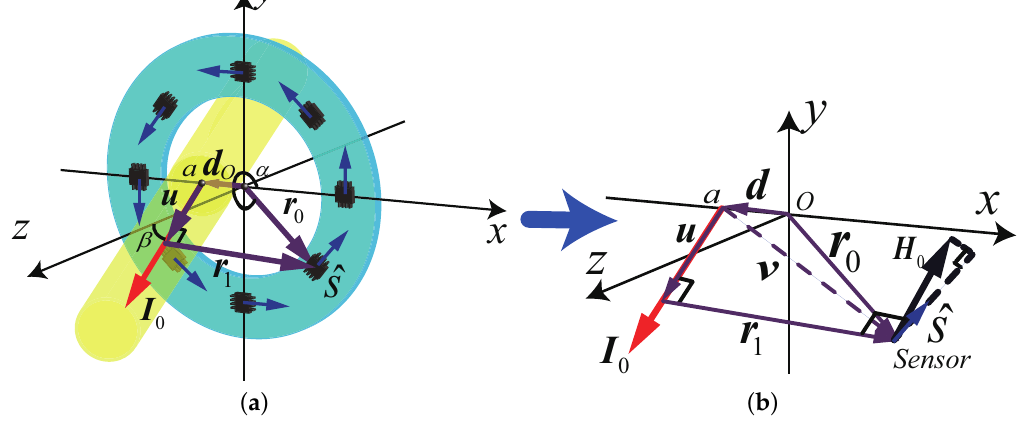
Figure 2. The error caused by the current-carrying conductor position: ( a ) Schematic of un-centeredness and un-perpendicularity; ( b ) The relationship of the key vectors Table 1. Parameters and vectors in Figure